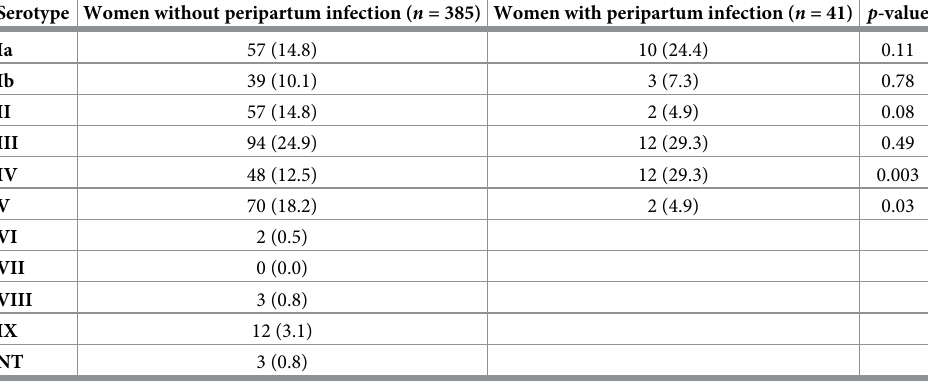
Table 3. Serotype distribution in women with and without peripartum